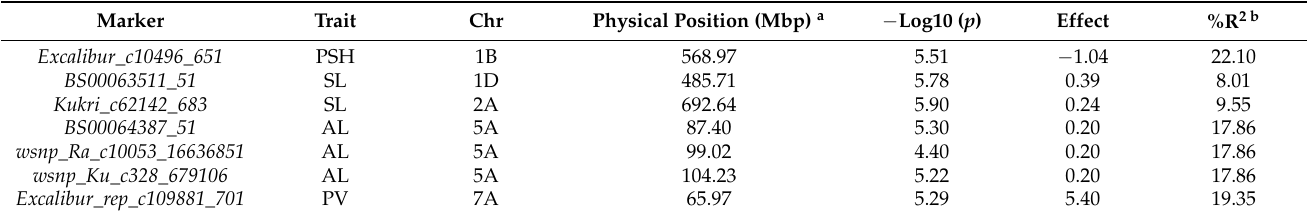
Table 2. Significant markers associated with pollen shedding, stigma length, anther length and pollen viability at FDR ≤ 0.05.